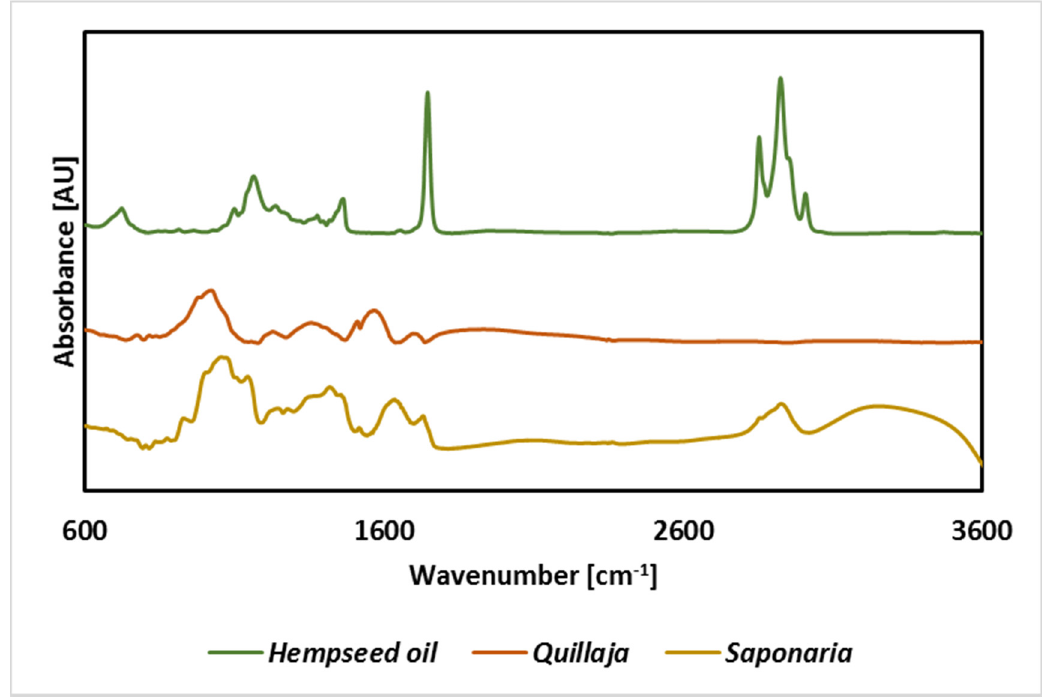
Figure 2. Infrared spectra of hempseed oil and used plant extracts from Saponaria officinalis and Quillaja saponaria .